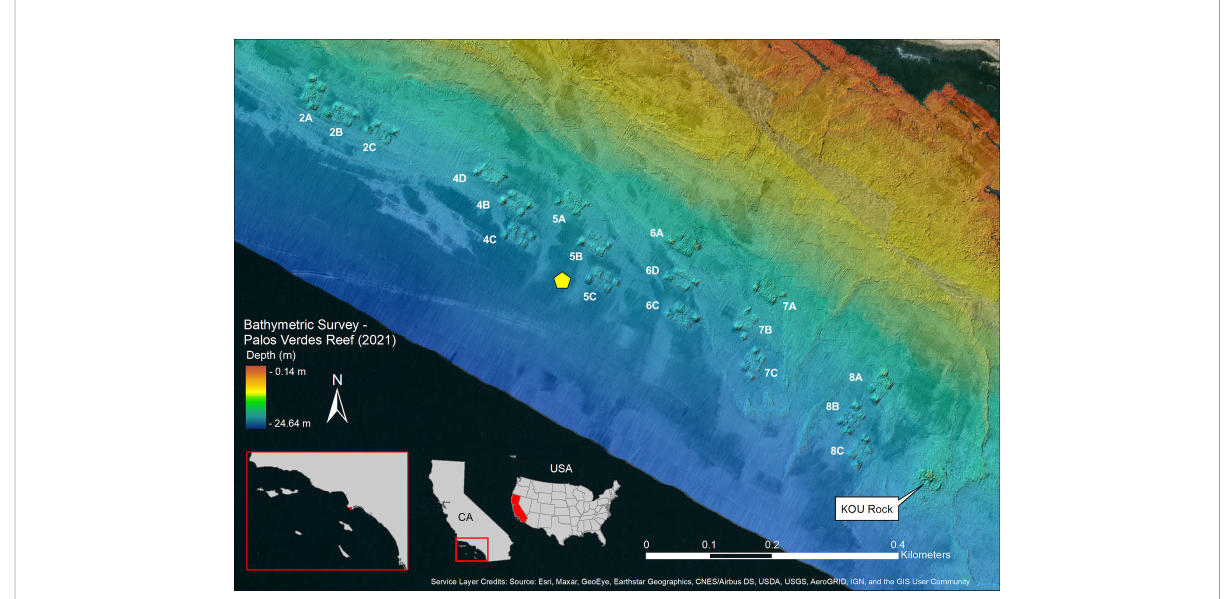
FIGURE 1 Finalized design of Palos Verdes Restoration Reef including bathymetry shaded relief and processed backscatter. Backscatter data are shown as a grayscale overlay where lighter areas indicate soft substrate and darker areas indicate either hard substrate or lightly buried hard substrate. Yellow pentagon indicates the position of the Spotter